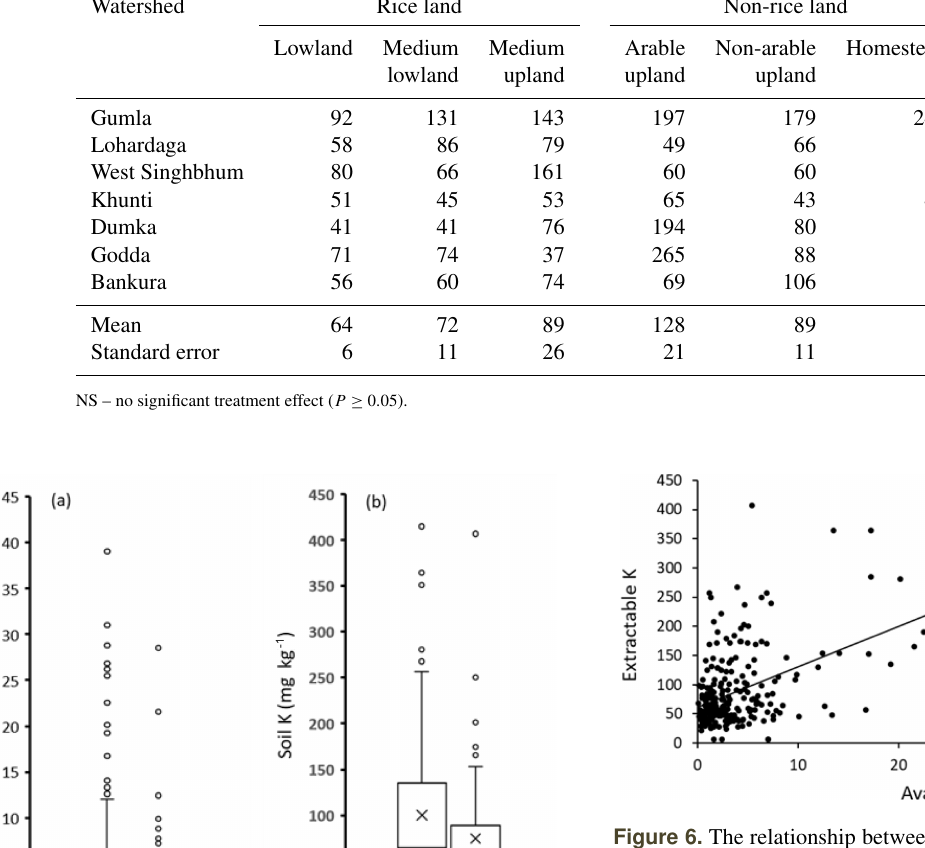
Figure 6. The relationship between available P (mgkg − 1 ) and ex- tractable K (mgkg − 1 ) in soils across seven EIP